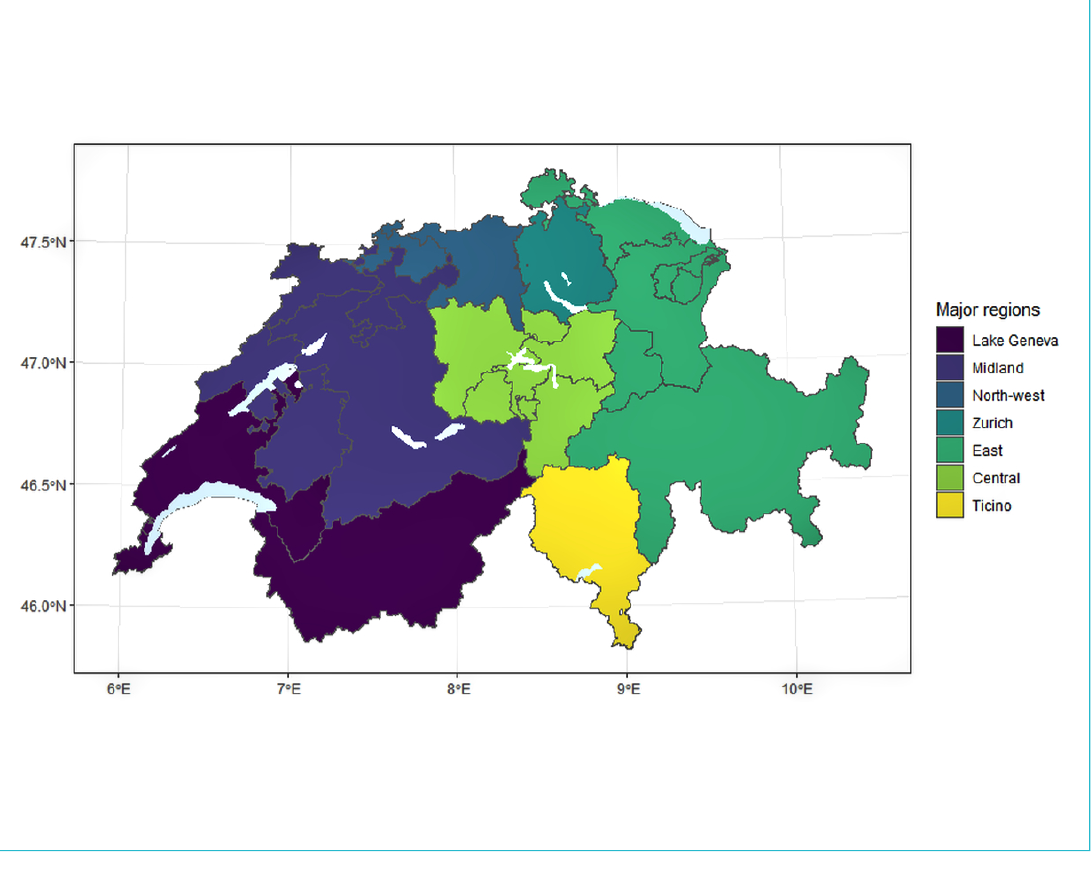
Figure S1: Topographical map of Switzerland, divided into seven major regions: Lake Geneva (cantons Vaud, Valais, Geneva); Midland (can- tons Bern, Fribourg, Solothurn, Neuchâtel, Jura); North-West (cantons Basel-Stadt, Basel-Landschaft, Aargau); Zurich (canton Zurich); East